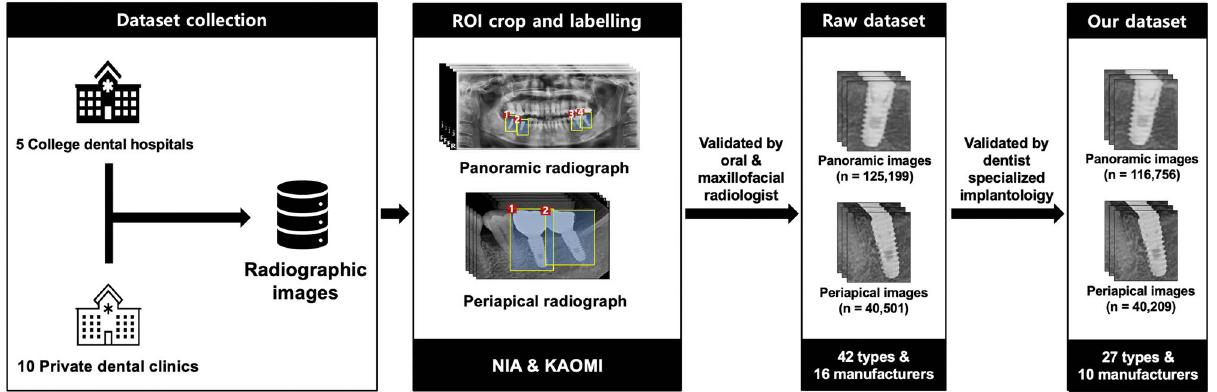
Figure 1. Schematic illustration of dataset collection and verification. All study protocols and related procedures were supervised by the National Information Society Agency (NIA) and the Korean Academy of Oral & Maxillofacial Implantology